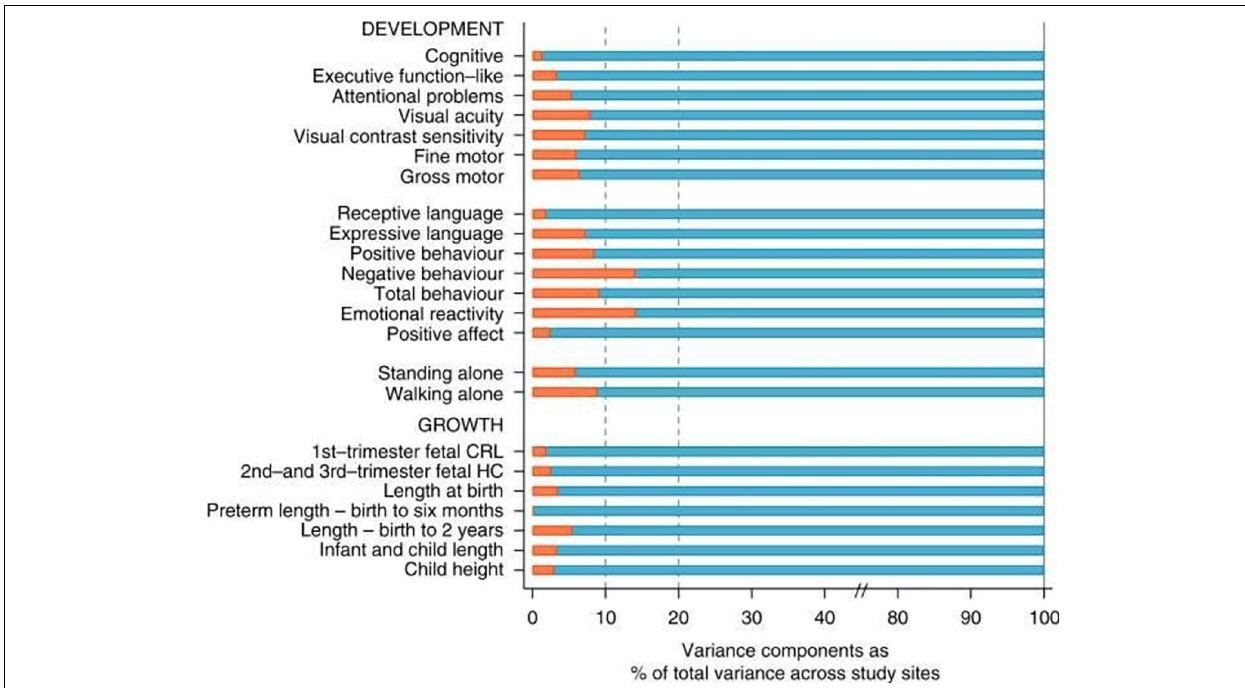
FIGURE 3 | Variance components analysis of 16 neurodevelopmental domains evaluated in the present study (Upper) and variance components analysis of 7 measures of fetal, newborn, infant, and child growth (Lower) . Red bars are the % of total variance explained by between sites variability (Villar et al., 2019).